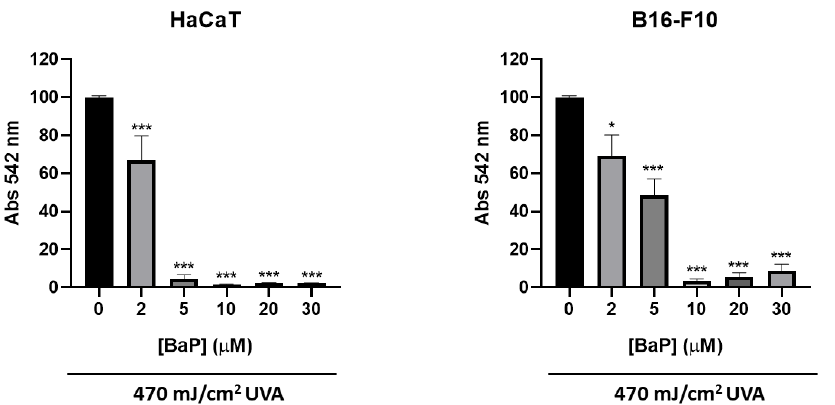
Figure 1. Effect of BaP plus UVA in HaCaT and B16-F10 cell lines. Cells were treated with different concentrations of BaP (2, 5, 10, 20 and 30 µM) for 48 h and immediately exposed to a dose of 470 mJ/cm 2 of UVA light. The results obtained from MTT assay revealed a decrease in cell survival as BaP concentration increased. Error bars denote ± S.E.M. ( n = 3, one-way ANOVA *: p < 0.05; ***: p < 0.001).